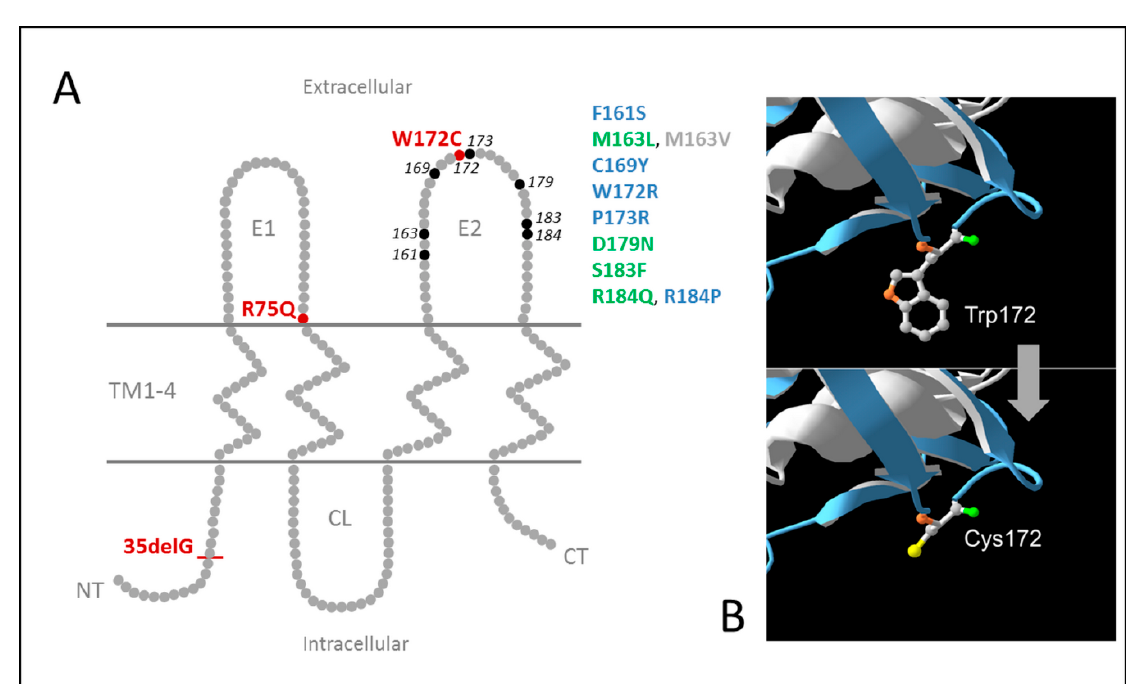
Figure 5. ( A ) Topological structure of Connexin 26. TM1-4—four transmembrane domains, E1 and E2—extracellular loops, CL—cytoplasmic loop, NT—N-terminal segment, CT—C-terminal segment. The variants p.Trp172Cys (W172C), p.Arg75Gln (R75Q), p.Gly12Valfs*2 (35delG) examined in this study are shown in red. Amino acid positions for ”pathogenic” and ”likely pathogenic” GJB2 variants located in E2 previously subjected to functional analysis [19,25,27,28,38,40,41,43,46,48,69,70] are marked in black. The mutations linked to recessive deafness are marked in blue; the mutations linked to dominant hearing loss (nonsyndromic and syndromic) are marked in green; ambiguously defined (recessive or dominant) mutation p.M163V is shown in grey. ( B ) Wild (Trp172) and mutant (Cys172) types of Cx26 (modified Figure 1 from [50]).